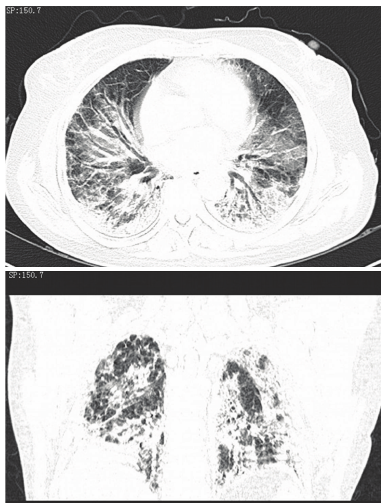
Figure 2: HRCT depicting di ff use areas of pulmonary infiltration, a bilateral geographic distribution of ground glass opacity and consolidation in the more dependent lung with associated traction bronchiectasis.